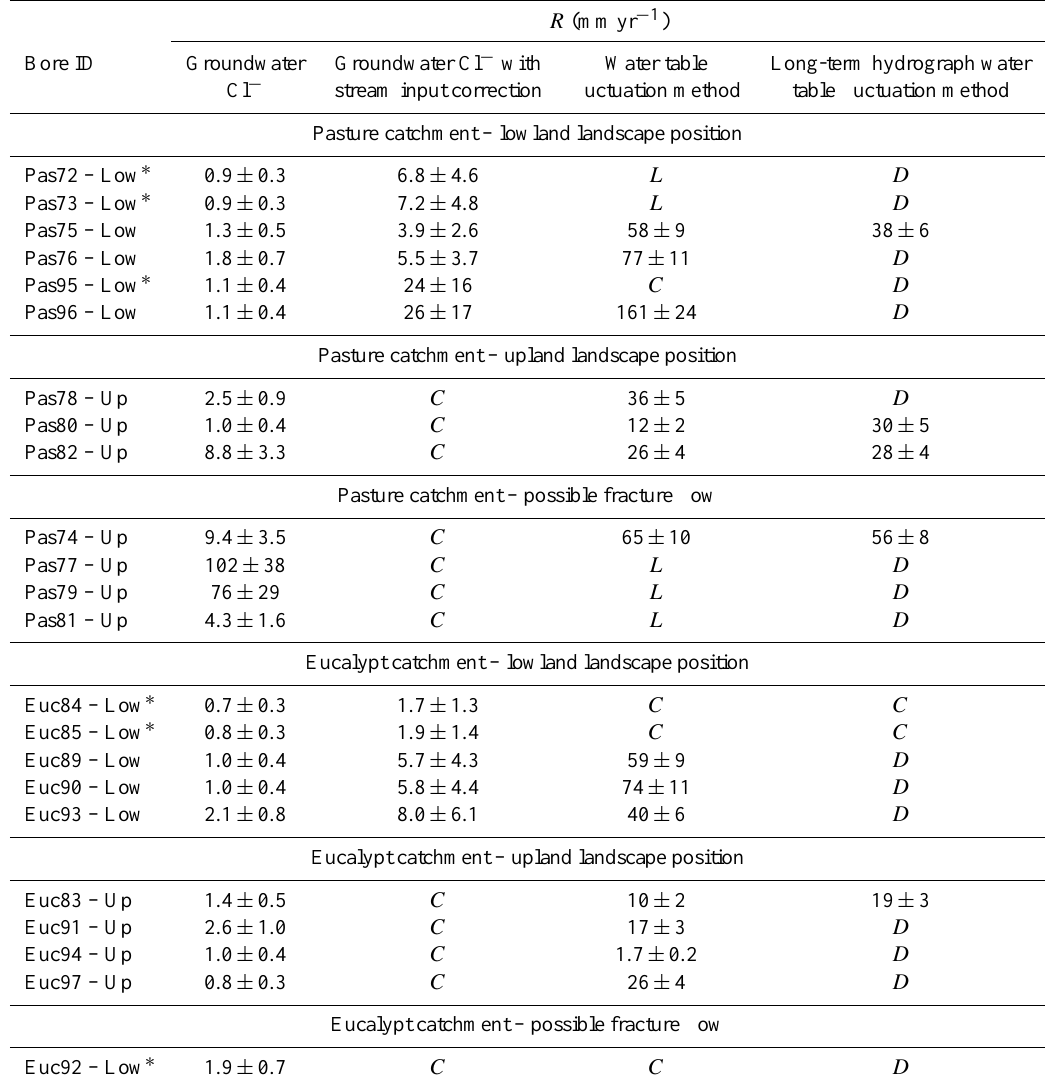
Table 3. Recharge ( R ) values using different methods for all the bores across both